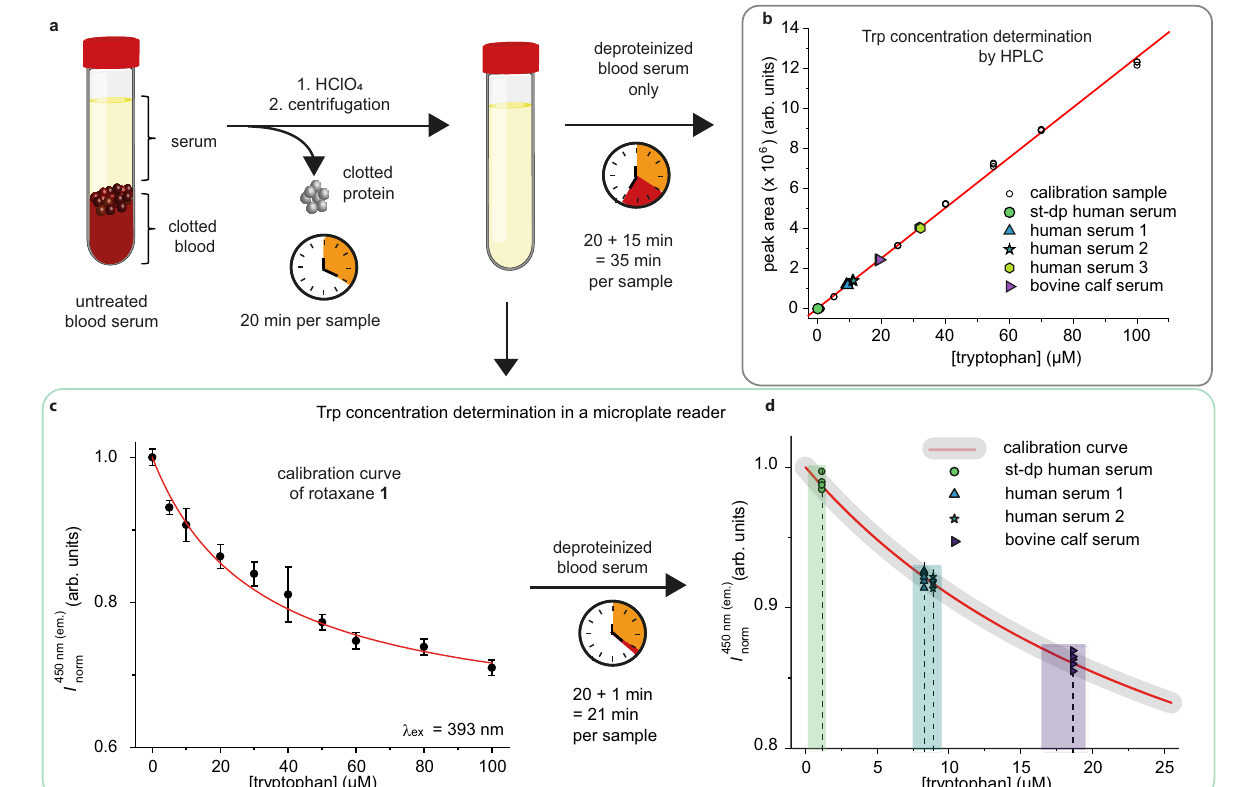
Fig.4|Tryptophandetectionindeproteinizedserumsampleswithrotaxane1. a Schematic representation of the state-of-the-art work fl ow for Trp quanti fi cation in blood serum by HPLC, including the mandatory deproteinization step. b Trp concentration levels of deproteinized serum samples (1:1 diluted with 624mM perchloric acid) obtained in an HPLC assay using an established calibration curve (single data points as black dots and linear fi t as red line), with n =3 independent measurements per serum sample and Trp concentration ( λ ex =285nm, λ em =353nm). c Microplate reader-based calibration curve (single data points as black dots and nonlinear fi t as red line) for Trp concentration determination with